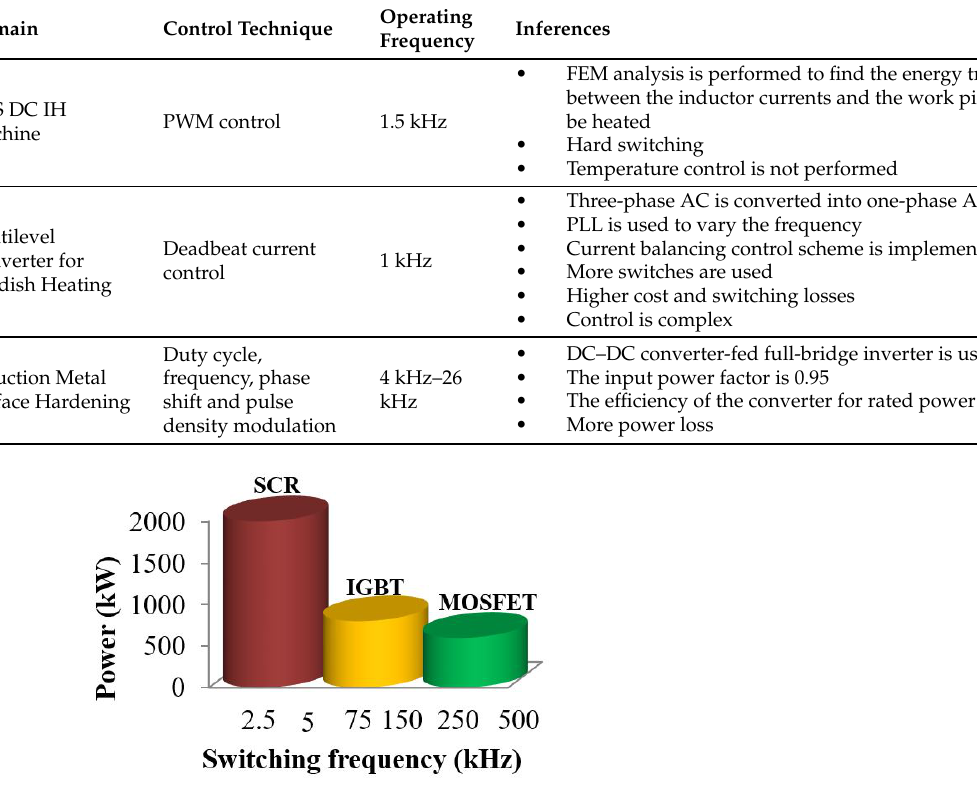
Table 6. Recent research connected to IH in industrial applications.